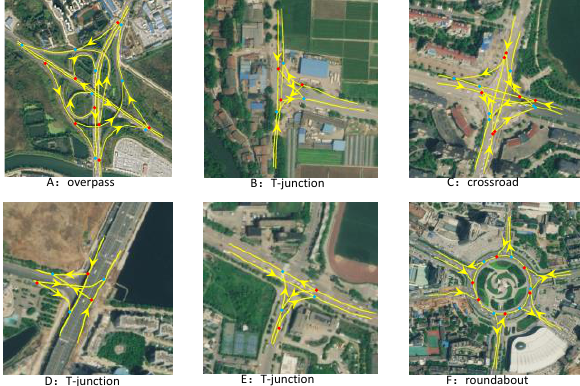
Figure 8. Finally geometry and traffic rules of different road intersections(red: entrances, blue: exit)